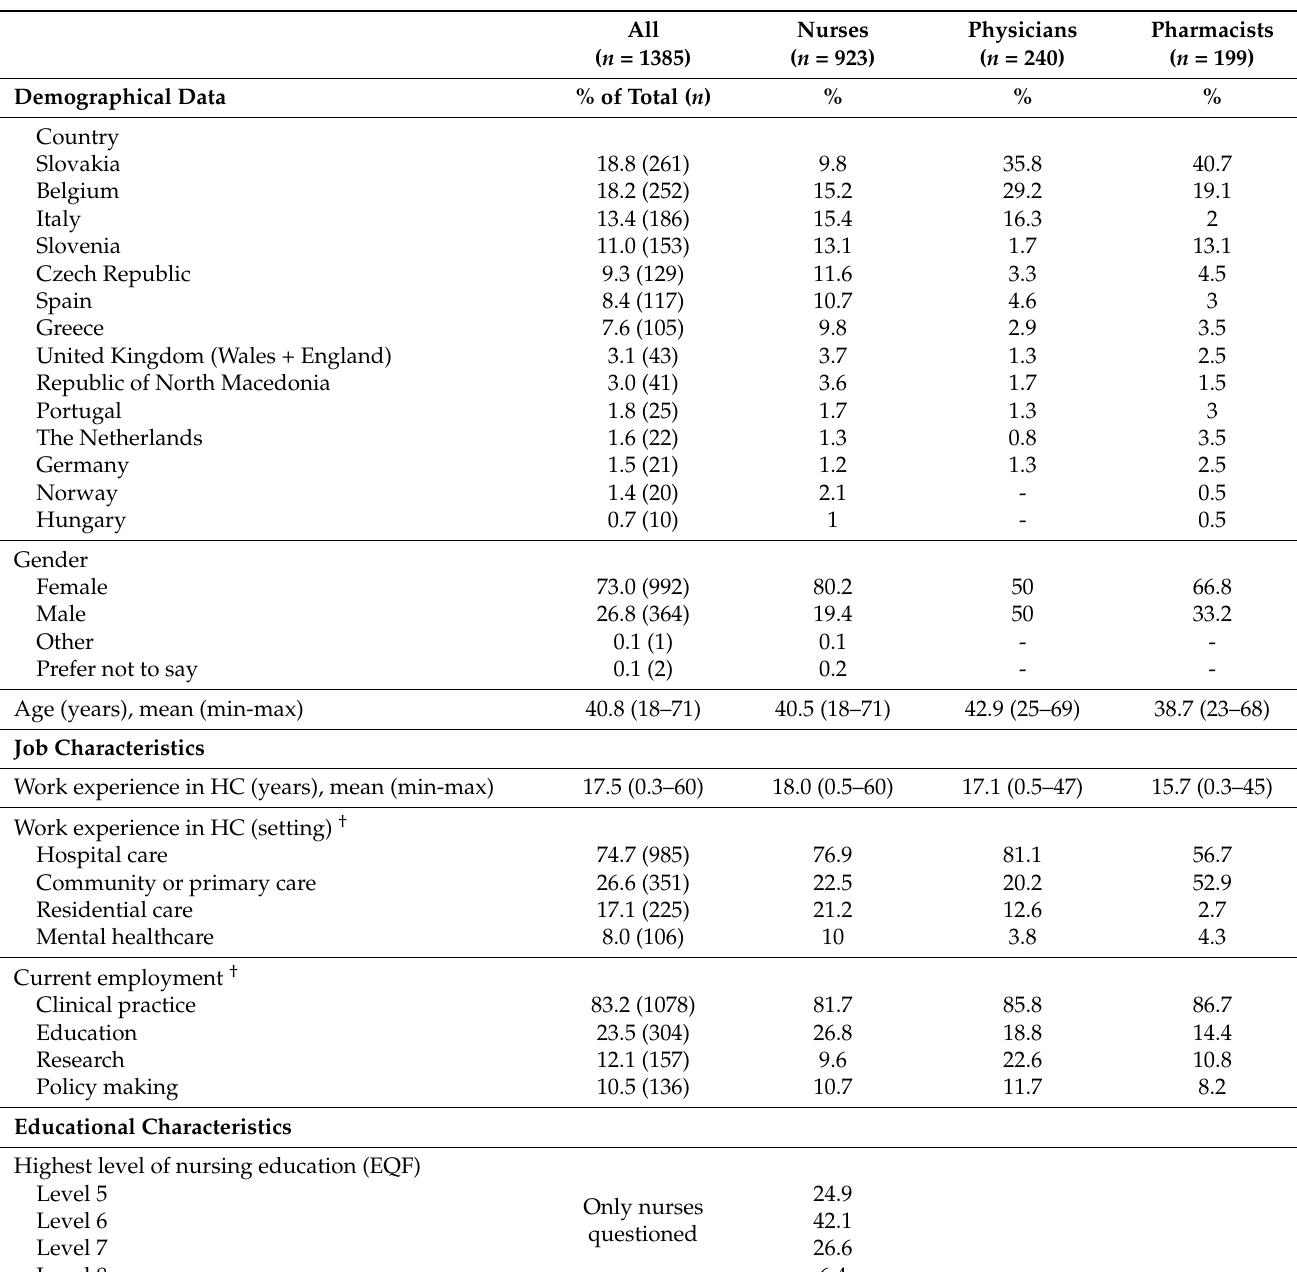
Table 2. Population characteristics ( n =